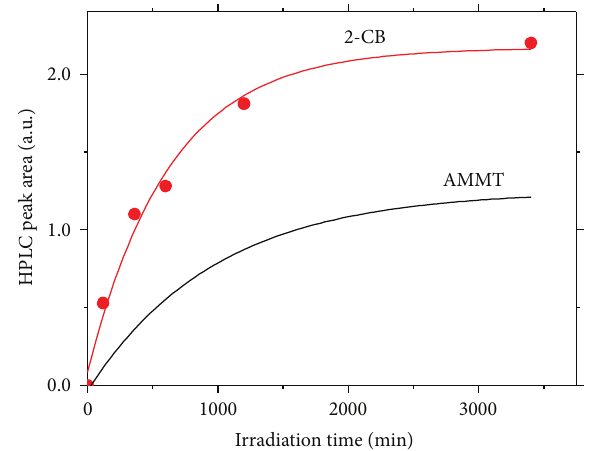
Figure 6: Formation of products 2-CB and AMMT upon excita- tion of metsulfuron methyl (MTSM) at the surface of Kaolinite. MTSM/Kaolinite [MTSM] = 5.2 𝜇 mol g −1 . Detection at 𝜆 max = 250 nm. Irradiation was performed in a Sunlight